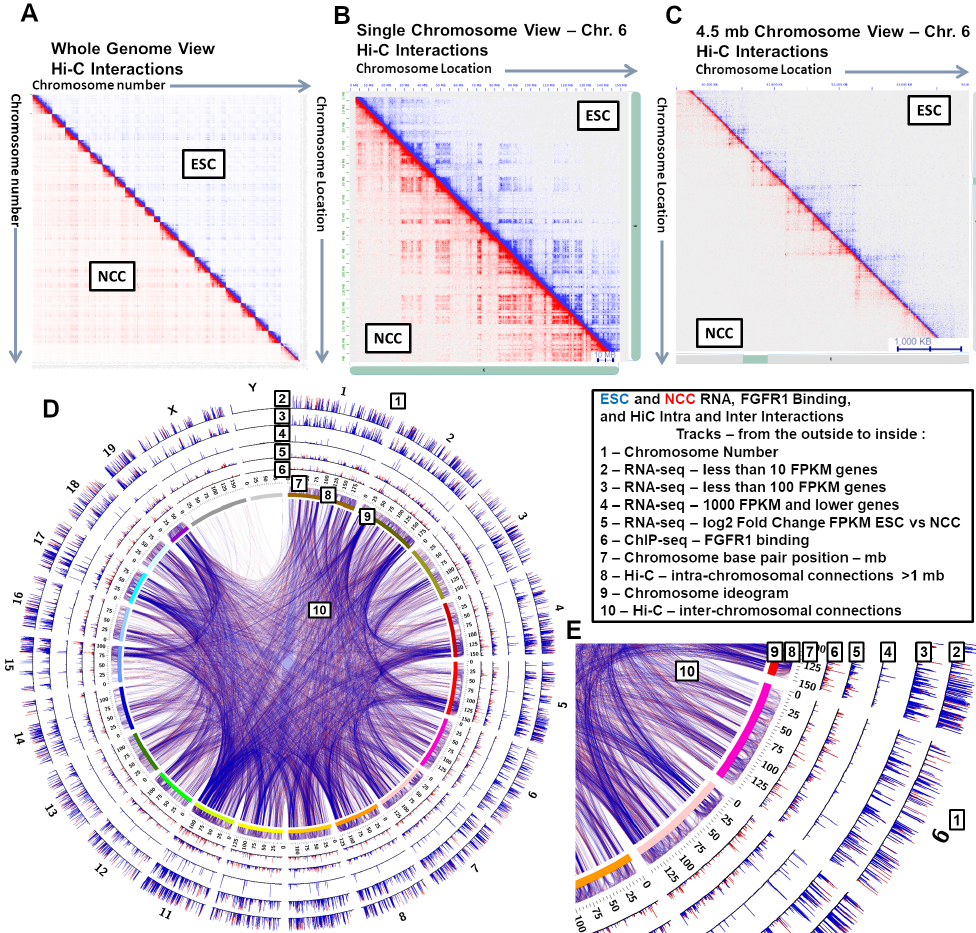
Figure 1. Chromatin interactions occur across the genome in both ESCs and NCCs. ( A ) Full genome inter- and intra-chromosomal contact map. ( B ) Chromosome 6 intra-chromosomal contact map. ( C ) 49.5–54.0 mb chromosome 6 contact map. ( D ) Genome-wide data overviews of RNA-seq and nFGFR1 binding and interactions in ESCs and NCCs. ( E ) Data overviews at Chromosome 6 for RNA-seq, nFGFR1 binding, and interactions in ESCs and NCCs. Values are shown for ESCs in blue and NCCs in